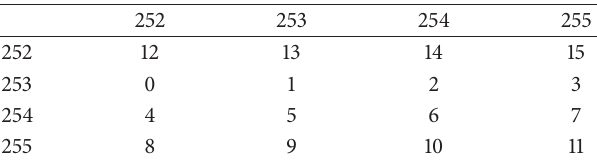
Table 1: The selected block.